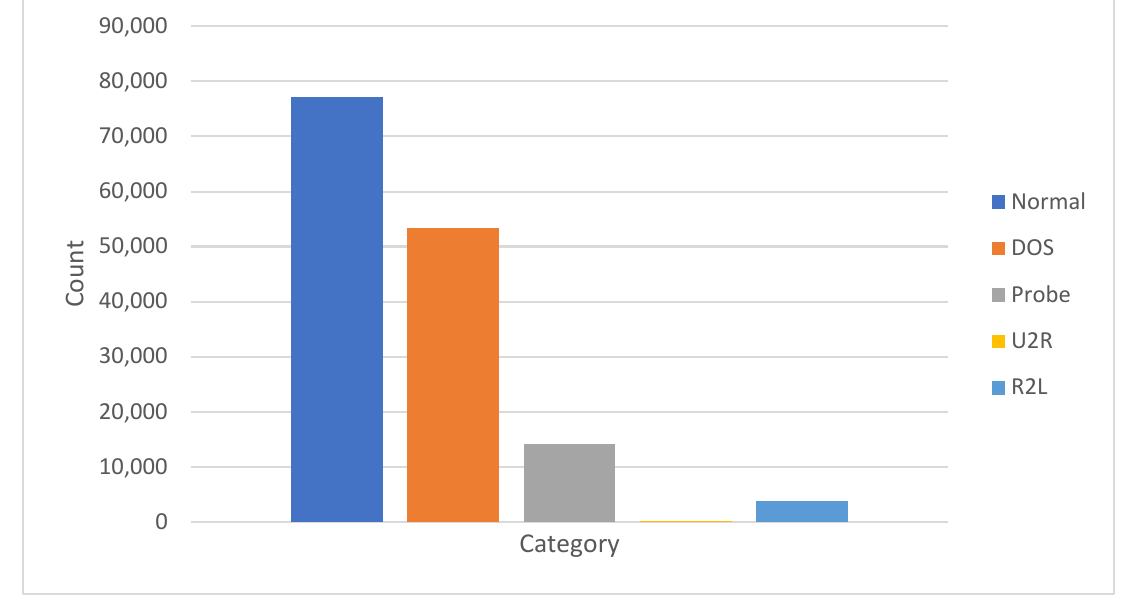
Figure 9. Dataset Label Distribution.